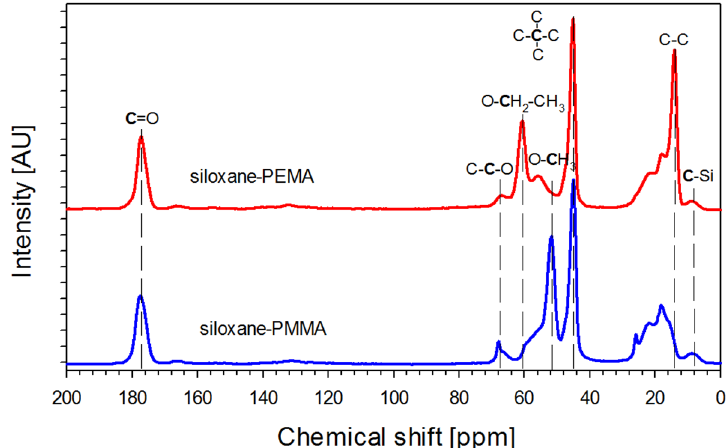
Figure 2. Solid state 13 C CP / MAS NMR spectra of the siloxane-hybrid monoliths prepared from TEOS, MAPTMS and two acrylates: methyl methacrylate (MMA) and ethyl methacrylate (EMA). Spectra were recorded for sols treated thermally for 1 h at 60 ° C and 1 h at 180 ° C.